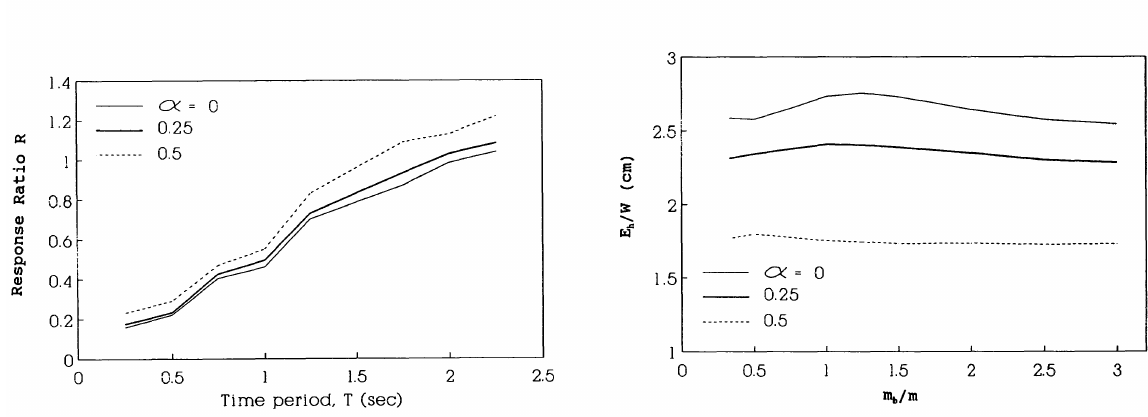
FIGURE 7 Plot of hysteretic energy dissipated against mass ratio mb1m; T = I sand Q/W =